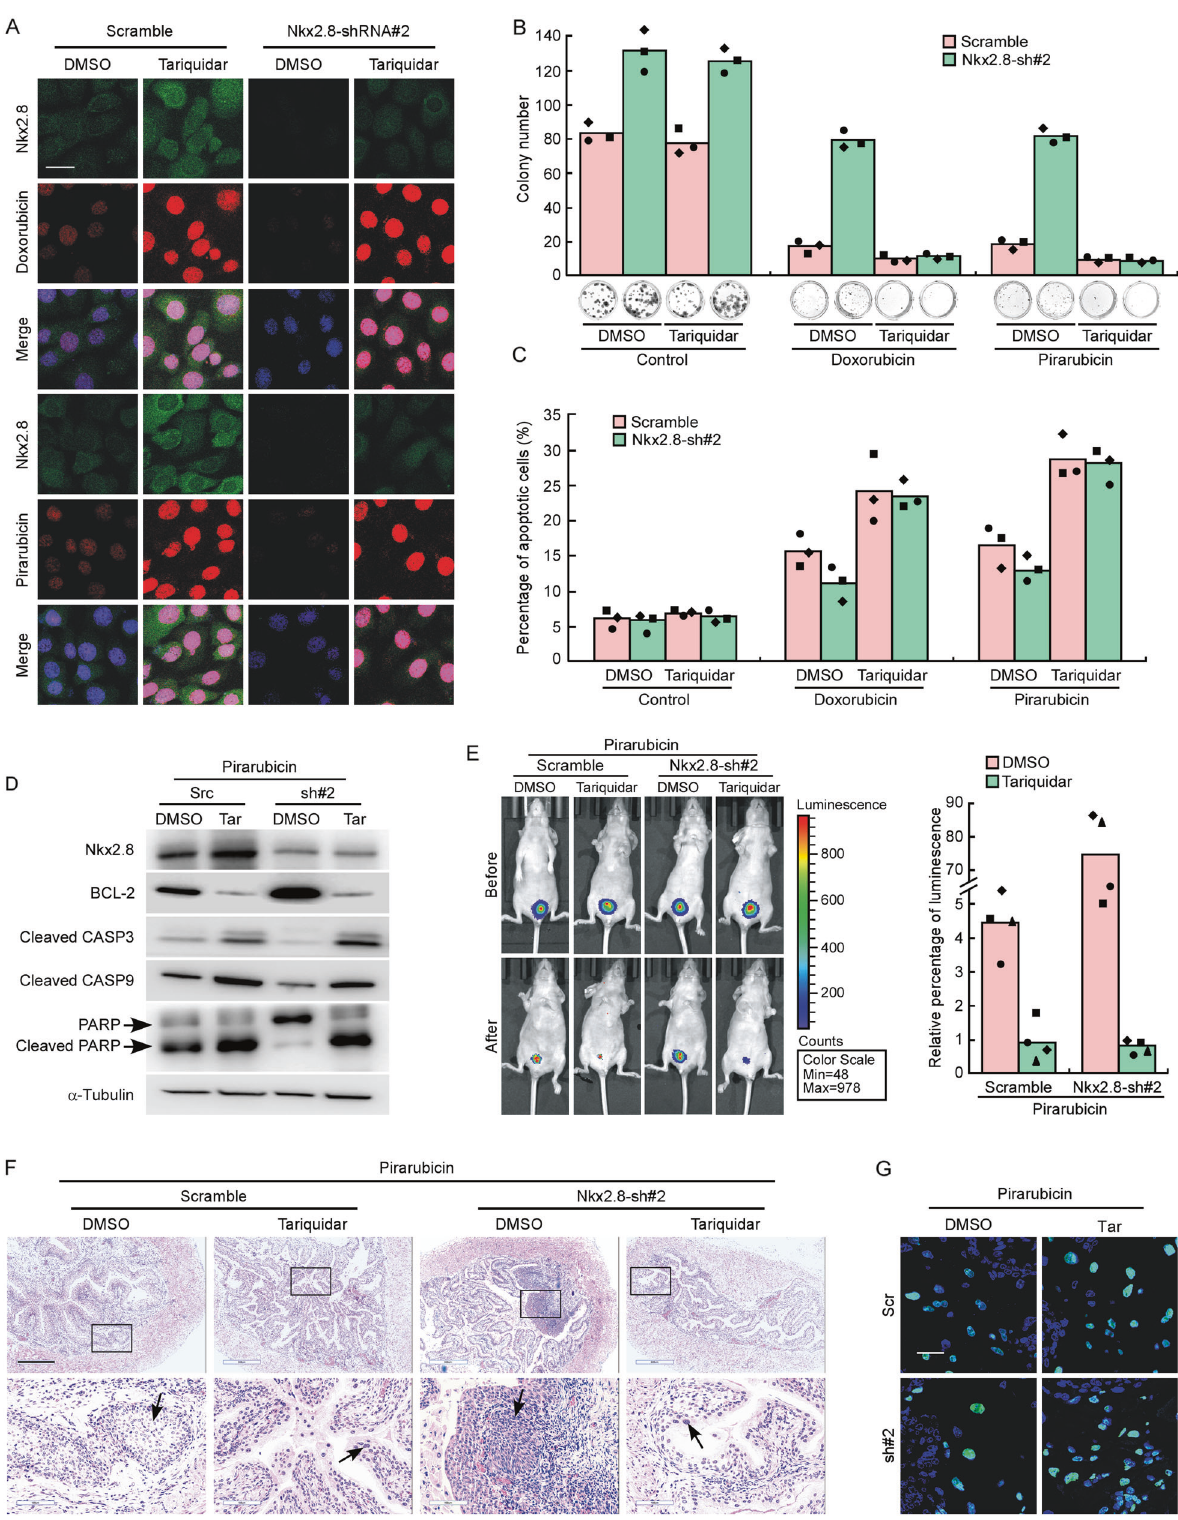
silenced cells after treatment with Doxorubicin or Pirarubicin (Figs. 6C and S5C). Western blotting analysis showed that after treated with Doxorubicin or Pirarubicin, the expression levels of cleaved- caspase3, cleaved-caspase9, cleaved-PARP and BCL-2 were recovered by Tariquidar (Figs. 6D and S5D).